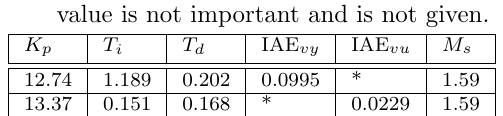
Figure 1: Control feedback system. The plant model is described by the process model H p ( s ) (Eq. (3)), PID controller, H c ( s ), (Eq. (2)) and disturbance model, H v ( s ), where, step dis- Table 1: E1. The table shows the optimal input and turbance, v , at the input when H v ( s ) = H p ( s ) and at the output when H v ( s ) = 1.